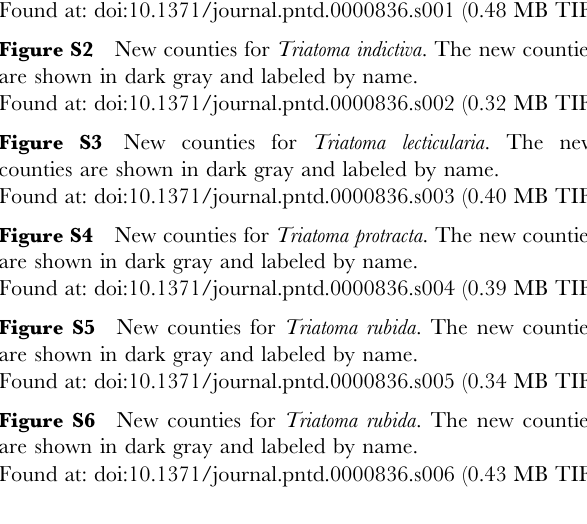
Figure S1 New counties for Triatoma gerstaeckeri . The new counties are shown in dark gray and labeled by name. Figure S2 New counties for Triatoma indictiva . The new counties are shown in dark gray and labeled by name. Figure S3 New counties for Triatoma lecticularia . The new counties are shown in dark gray and labeled by name. Figure S4 New counties for Triatoma protracta . The new counties are shown in dark gray and labeled by name. Figure S5 New counties for Triatoma rubida . The new counties are shown in dark gray and labeled by name. Figure S6 New counties for Triatoma rubida . The new counties are shown in dark gray and labeled by